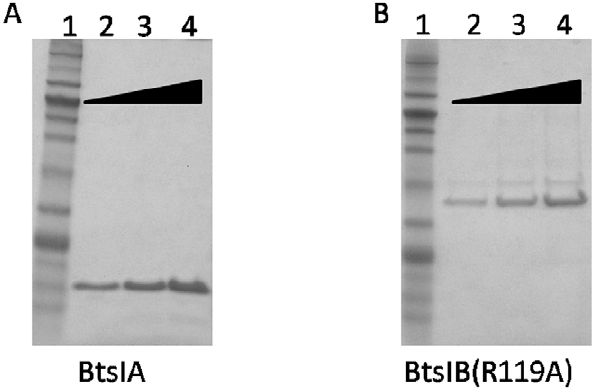
Figure 1. Purification of BtsIA and BtsIB(R119A) with IMPACT system. 1 m l (lane 2), 2 m l (lane 3) and 4 m l (lane 4) of eluted BtsIA protein (A) or BtsIB(R119A) (B) were resolved by SDS-PAGE and stained with Coomassie Blue. Lane 1: protein ladder (NEB # P7711S)